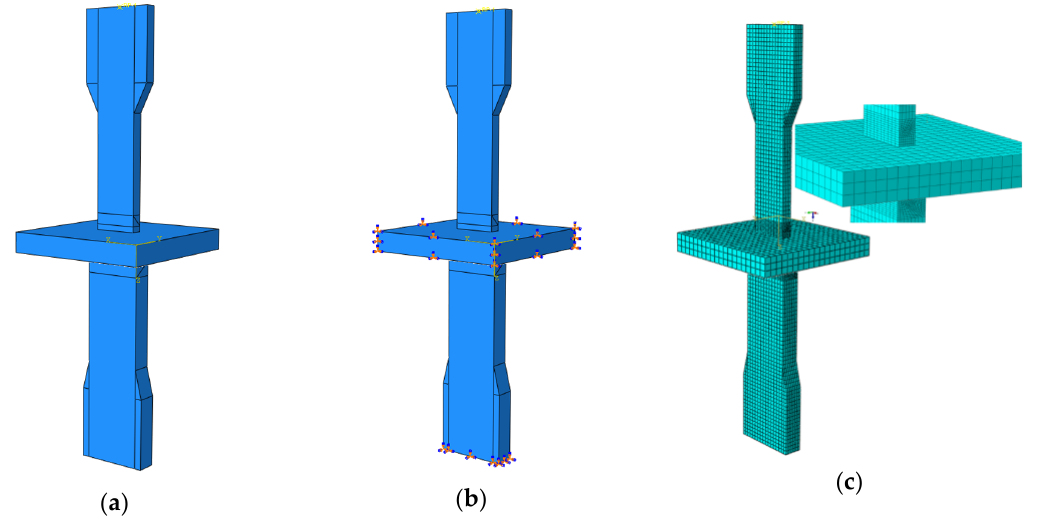
Figure 15. Finite element analysis model: ( a ) welded plate joint model; ( b ) loading and boundary conditions; ( c ) grid diagram.